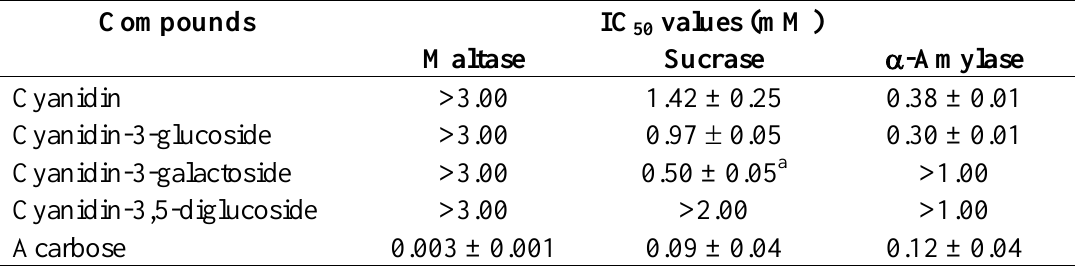
Table 1. The IC values for intestinal  -glucosidase (maltase and sucrase) and pancreatic 50  -amylase by cyanidin and its